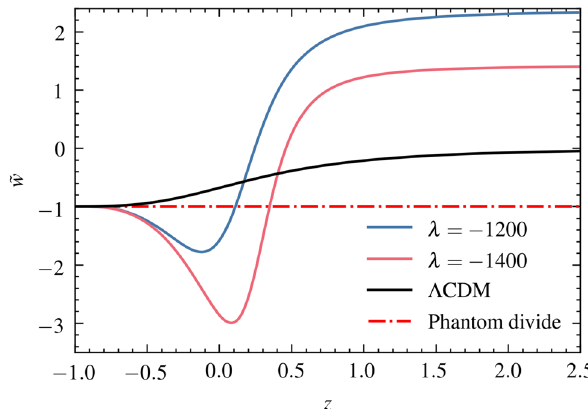
Fig. 5 Total equation of state ( ˜ w ) as a function of redshift ( z ) for dif- ferent values of λ . Phantom divide is at ˜ w = − 1 (with (cid:12) m 0 = 0 . 315 and H 0 = 67 . 4 km/s/Mpc [78])